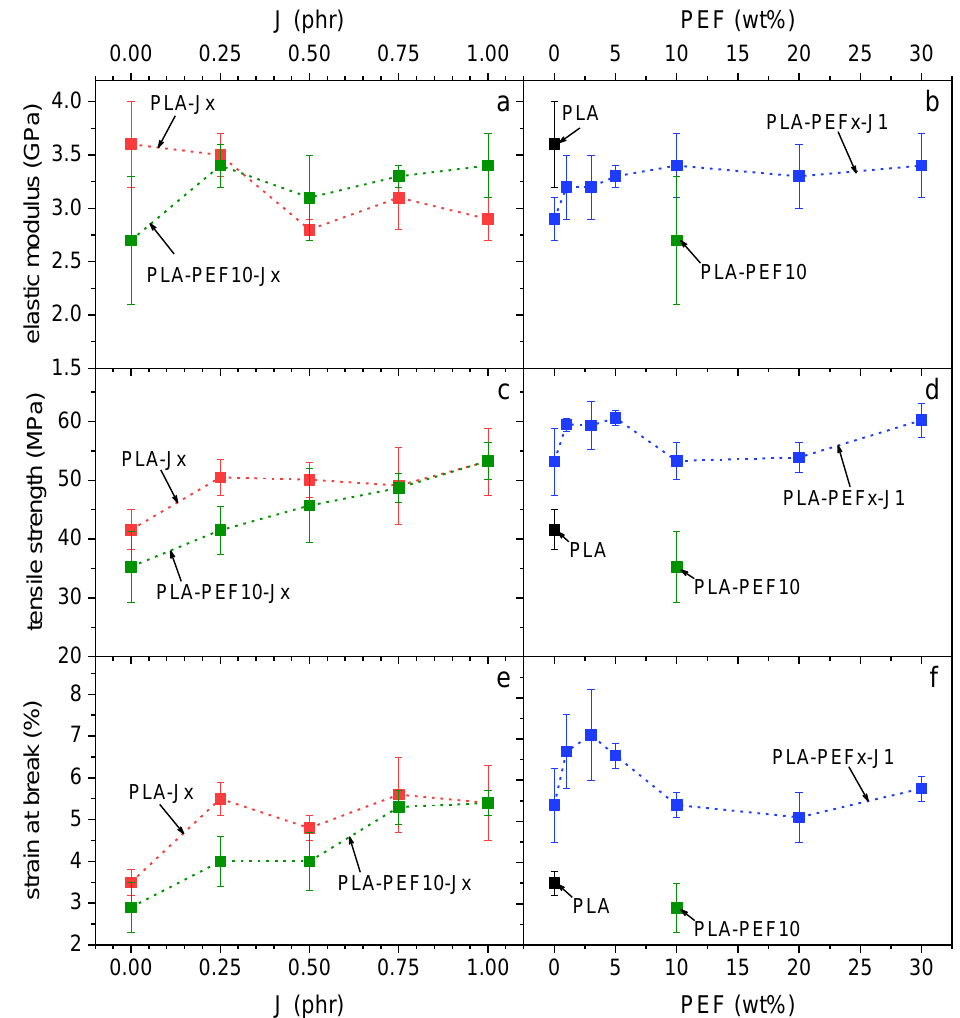
Figure 9. Main results of the tensile tests on the prepared samples as a function of the J content ( a , c , e ) and of the PEF weight fraction ( b , d , f ). ( a , b ) Elastic modulus; ( c , d ) tensile strength; ( e , f ) strain at break.